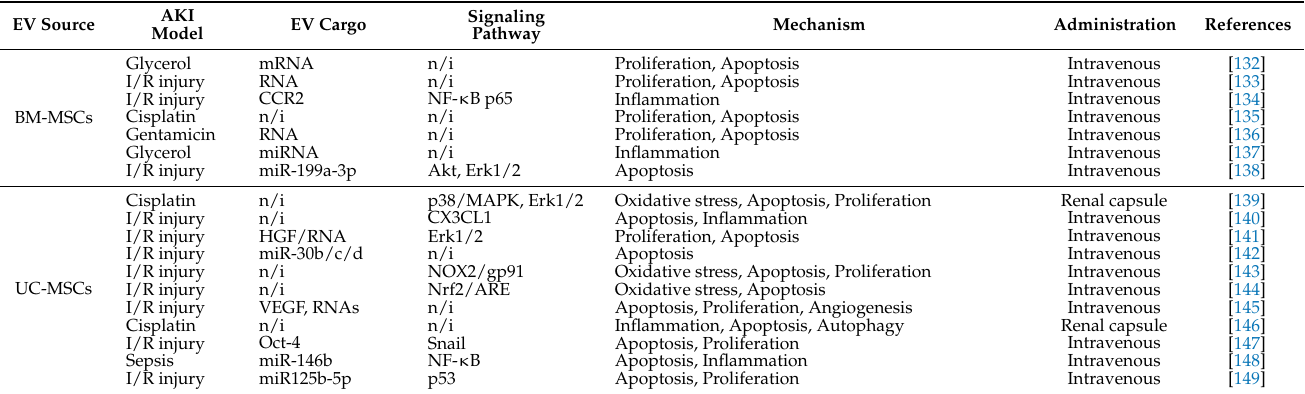
Table 1. Application of EVs as therapeutic agents in acute kidney